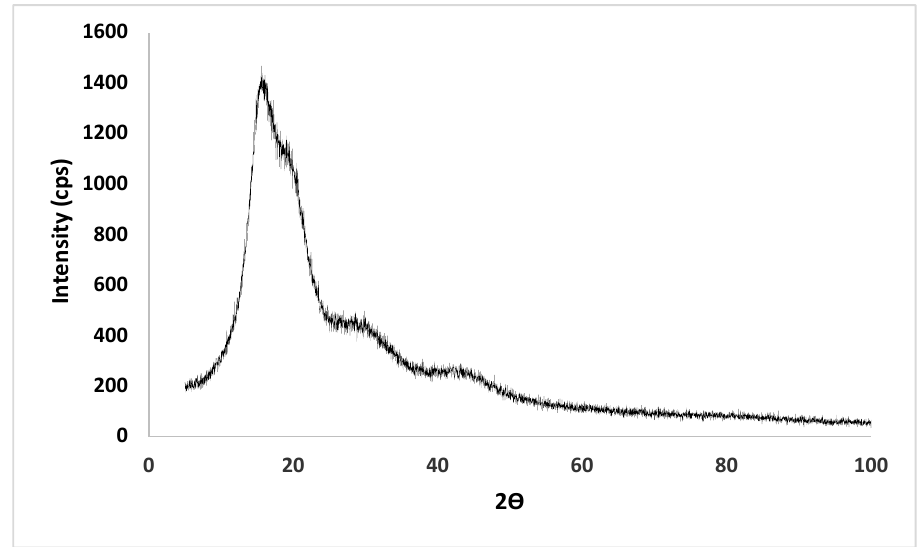
Figure 5. X-ray diffraction patterns for the hyperbranched polyester powder.